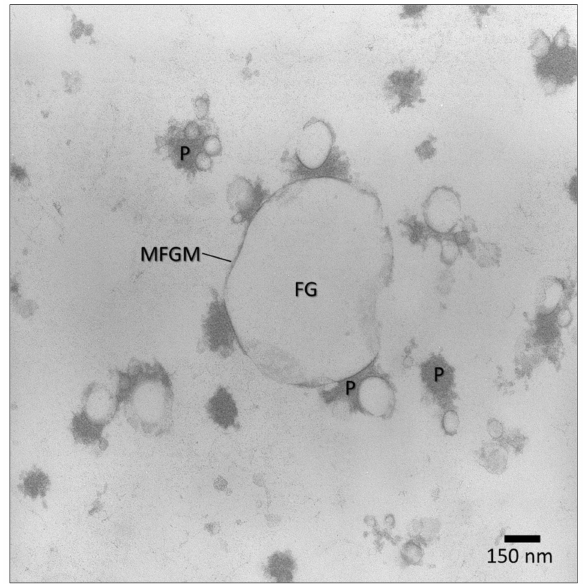
Figure 5. Transmission electron microscopy of fat globules (FG) and protein (P) in homogenized pasteurized milk. The sample was prepared as described by D’Incecco et al. 2018 [66]. MFGM = milk fat globule